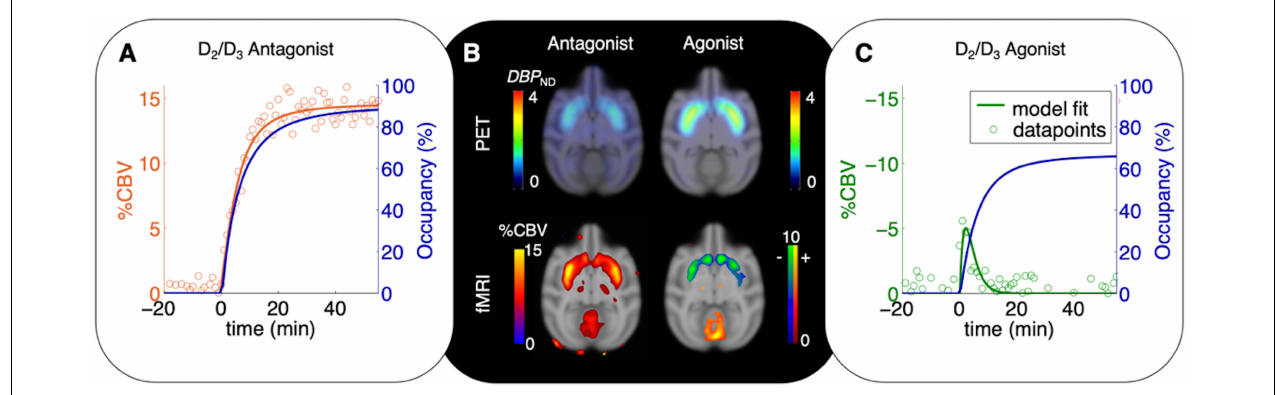
FIGURE 2 | Time-varying occupancy ( blue ) and cerebral blood volume (CBV) responses [positive ( orange ) or negative ( green ) percent change] due to a pharmacological response from the D 2 /D 3 antagonist prochlorperazine (A) and the D 2 /D 3 agonist quinpirole (C) in non-human primates. Occupancy curves are derived from a time-varying specific binding term during kinetic modeling, and the CBV curves are fitted using the general linear model. (B) 11 C-raclopride-PET binding potential maps ( upper row ) and CBV maps shown at peak value of the dynamic modeling term (Sander et al., 2015).